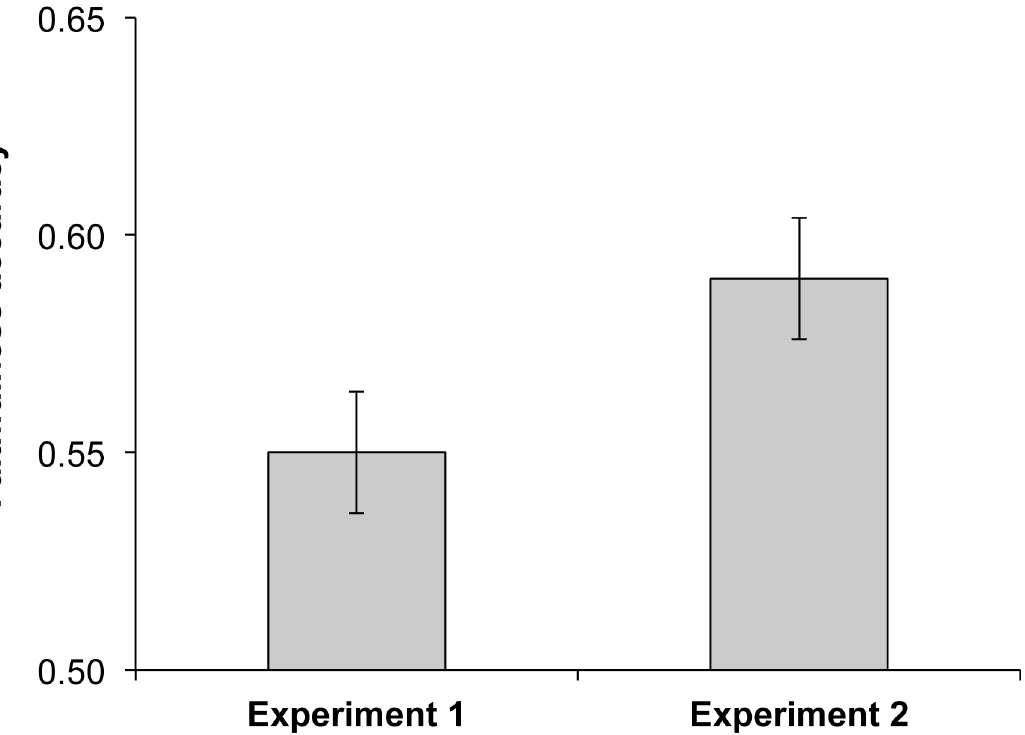
Fig 1. Faithfulness accuracy (proportion of trials in which the faithful model was correctly chosen in a forced choice task) in Experiment 1 and Experiment 2. The x-axis represents chance level (0.5) and S.E bars are shown.